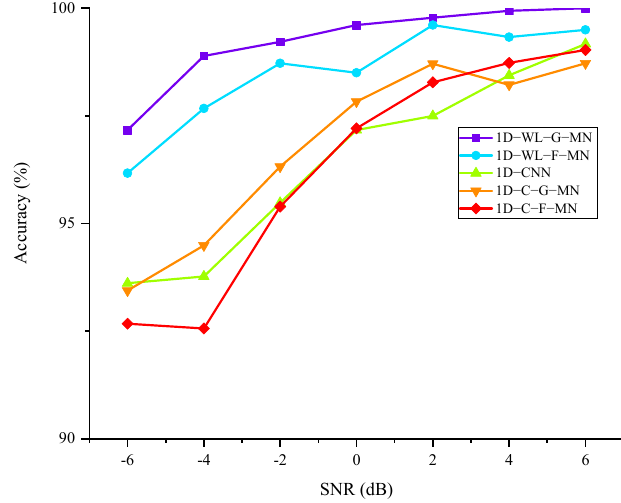
Figure 12. Comparison of anti-noise performance of the models.